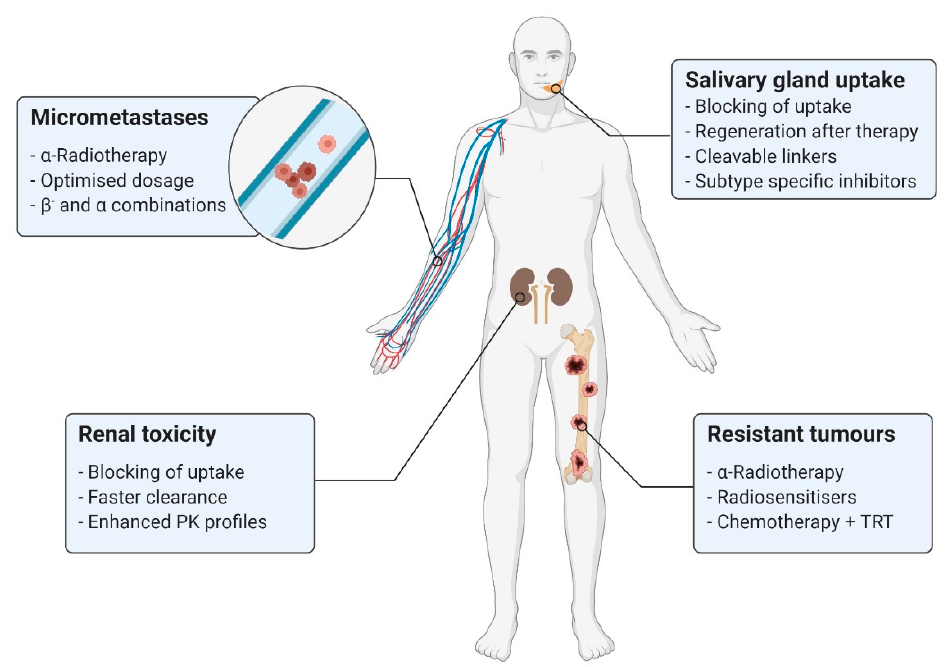
Figure 4. The main challenges associated with clinical PSMA-TRT and possible approaches to overcome these limitations.